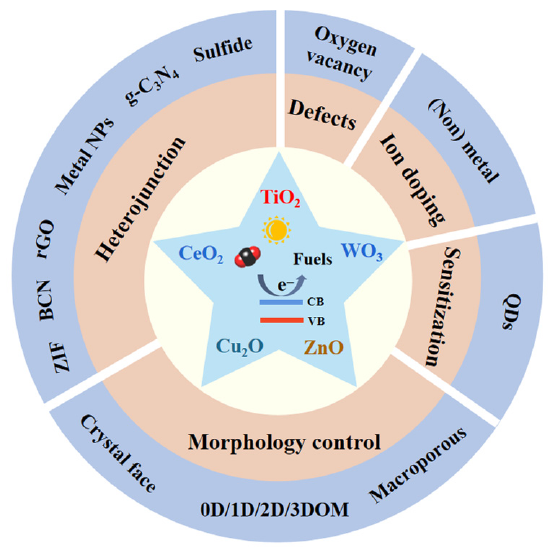
Figure 3. Strategies to boost the photocatalytic CO 2 reduction.